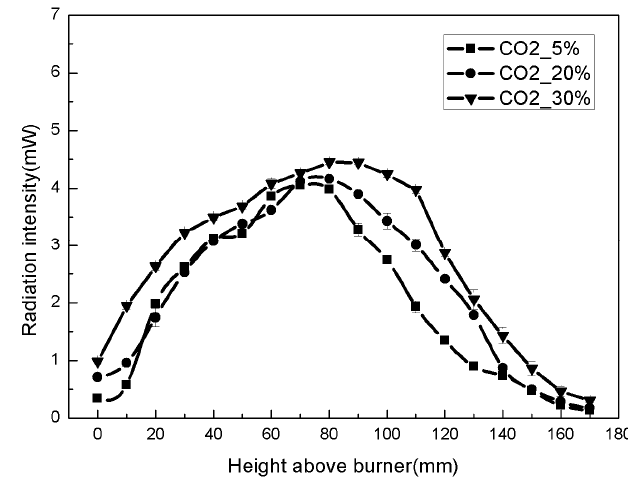
Figure 12. Effect of CO 2 addition on radiation intensity.